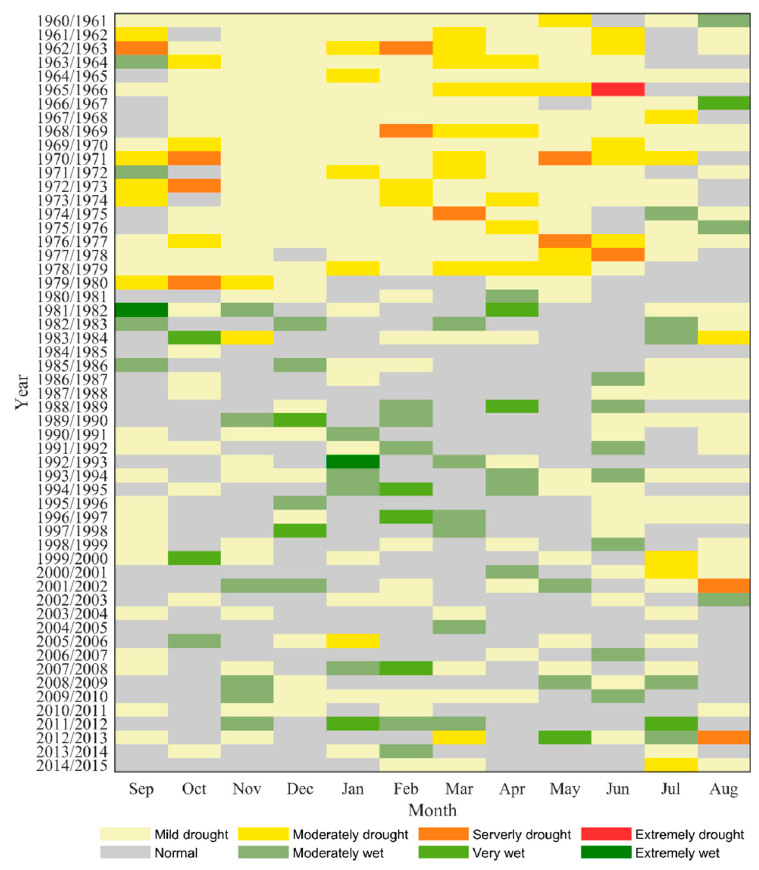
Figure 6. Intra-annual distribution of drought and wetness over SRYRB during 1960–2015. Table 4. Intra-annual frequency (%) of drought and wetness over SRYRB during 1960–2015.